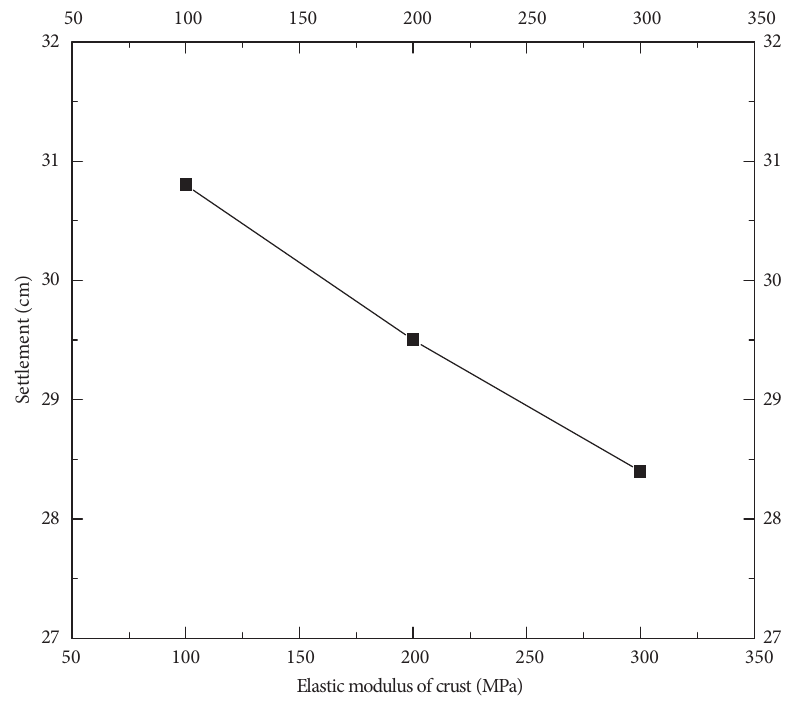
Figure 12: Settlement versus the elastic modulus of crust.